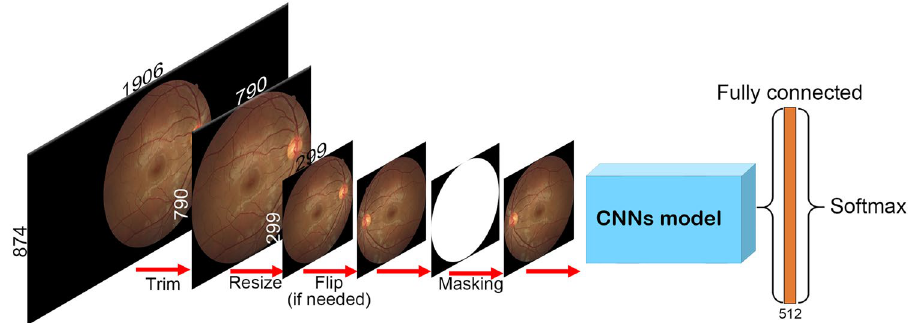
Figure 4. Diagram of the research process. The edges of the images were trimmed to decrease the image size from 1906 × 874 to 790 × 790 pixels. The images were then re-sized to 299 × 299 pixels. If needed, the images were flipped horizontally. A round mask was used to create identically shaped images. The processed images were loaded into CNNs connected to the fully connected and softmax